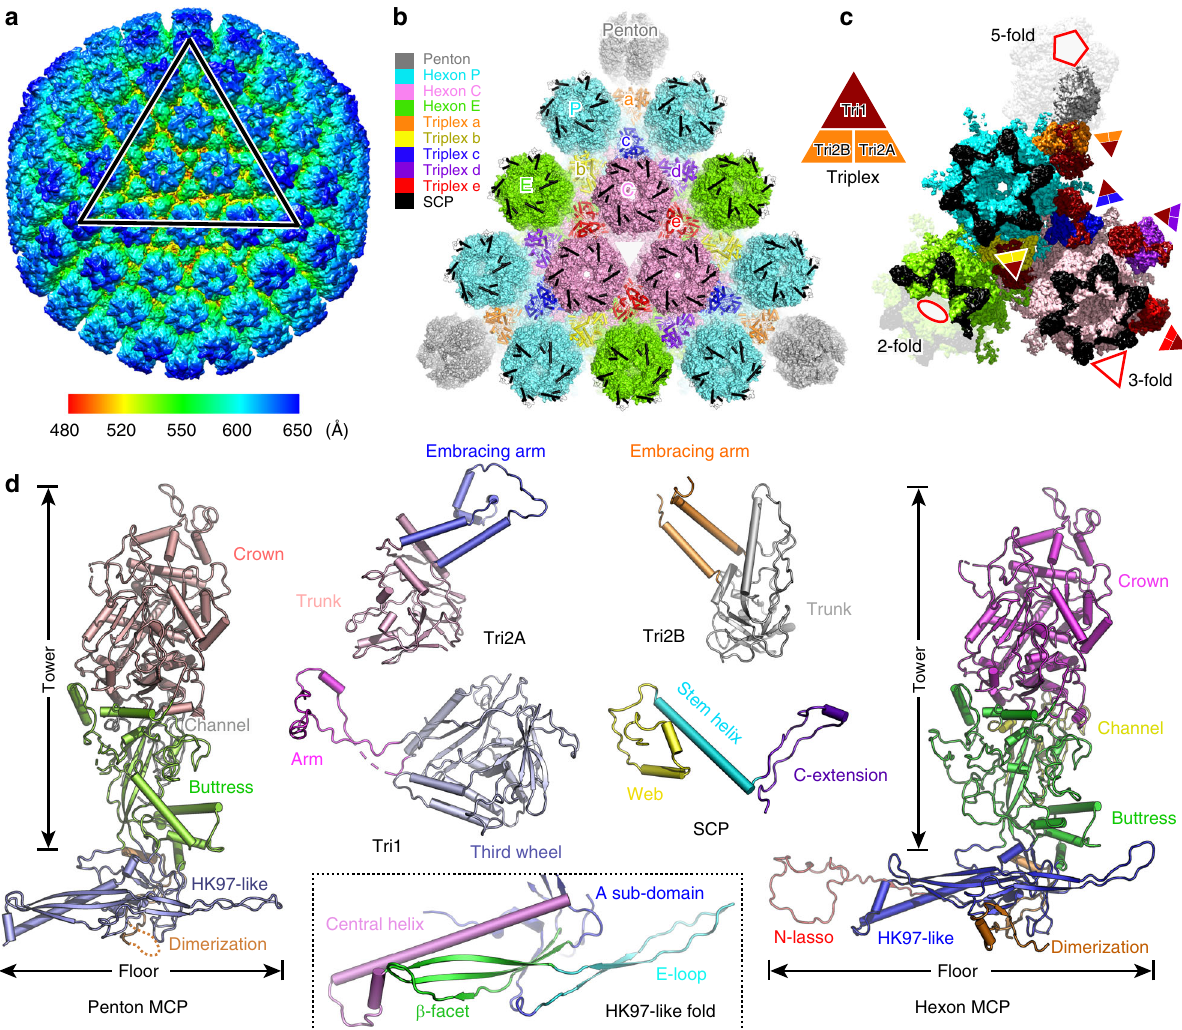
Fig. 1 Overall architecture of VZV A-capsid. a Density map of the icosahedral VZV A-capsid, colored by radius with the scheme below. An icosahedral facet is indicated by a triangle. b Organization of the capsid proteins within a facet. The symmetry-related molecules are represented by the same color. There are three types of hexons (P, C, and E) and fi ve heterotriplexes (a – e) with unique molecular contexts in the capsid. The MCP is shown in surface, and the SCP and heterotriplex proteins are shown as cartoon models. c The density map of an ASU, colored by proteins. The MCPs in different capsomers are colored in the same scheme as used in ( b ). A schematic diagram of the heterotriplex assembly is shown to facilitate visualization of its orientation at different sites. d Atomic structure of each capsid protein, colored by domains. The inset shows the close-up view of the HK97-like fold in the fl oor of